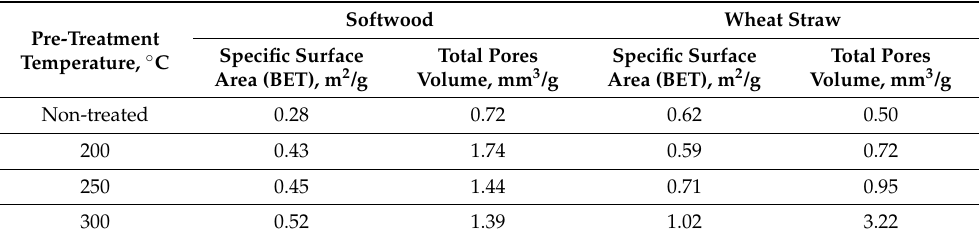
Table 2. Characteristics of porous structure of MW pre-treated and non-treated biomass determined Brunauer–Emmett–Teller (BET) method